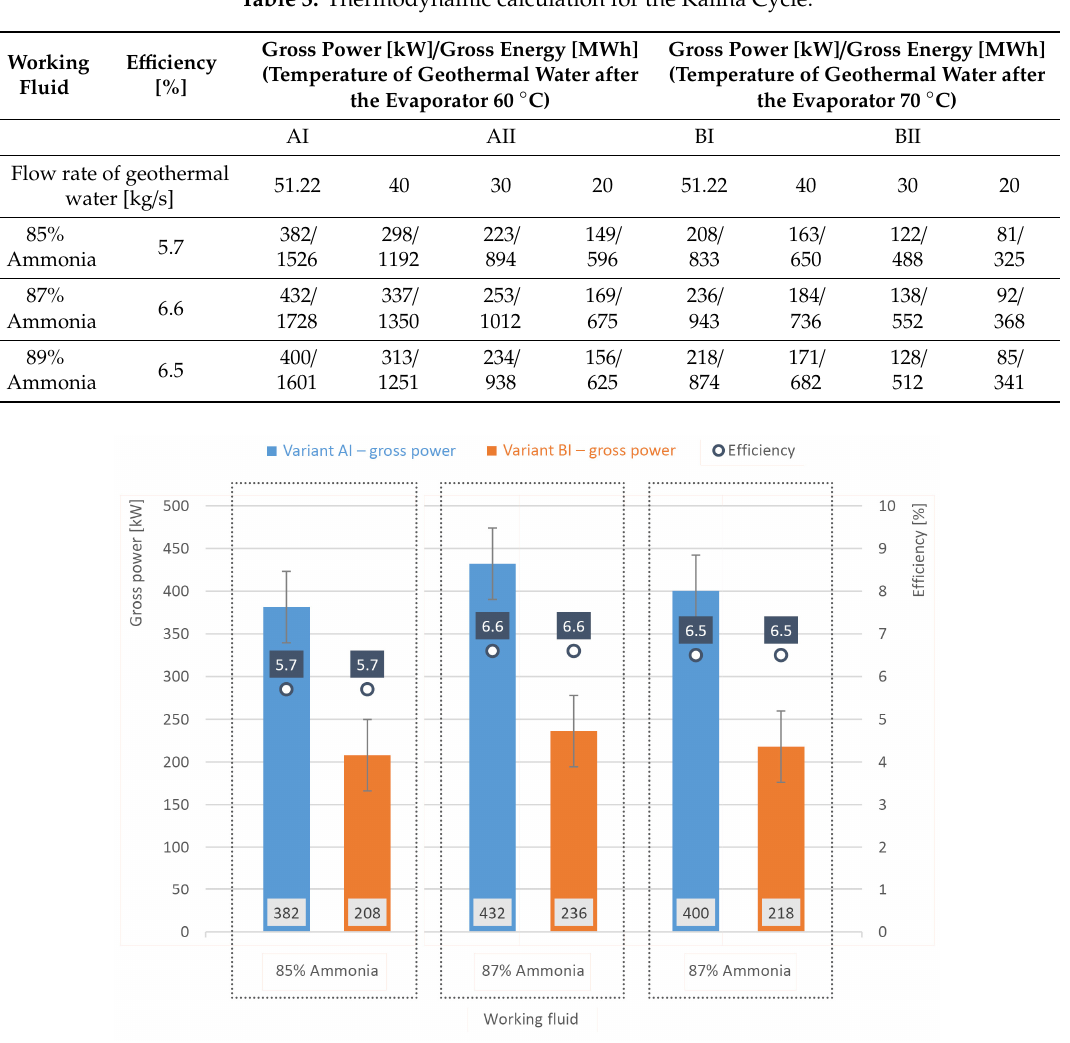
Figure 7. Comparison of results for gross power and e ffi ciency obtained in variants AI and BI using the Kalina Cycle.